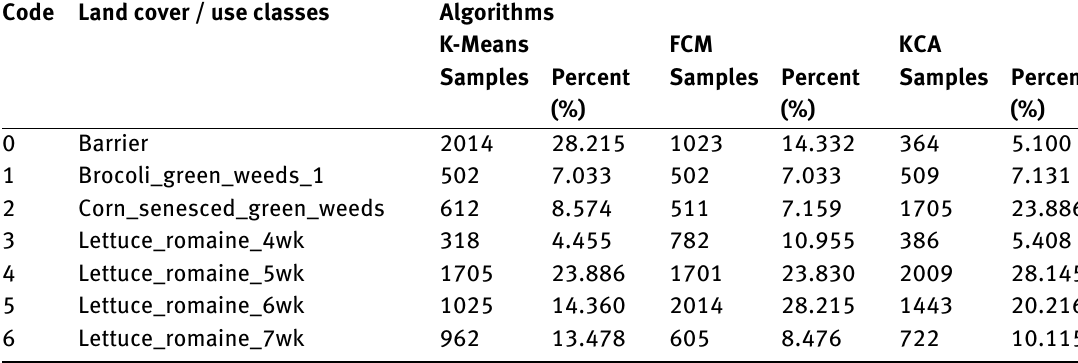
Table 5: Land cover/use classes on Salinas A dataset obtained by K-Means, FCM and KCA algorithms Code Land cover / use